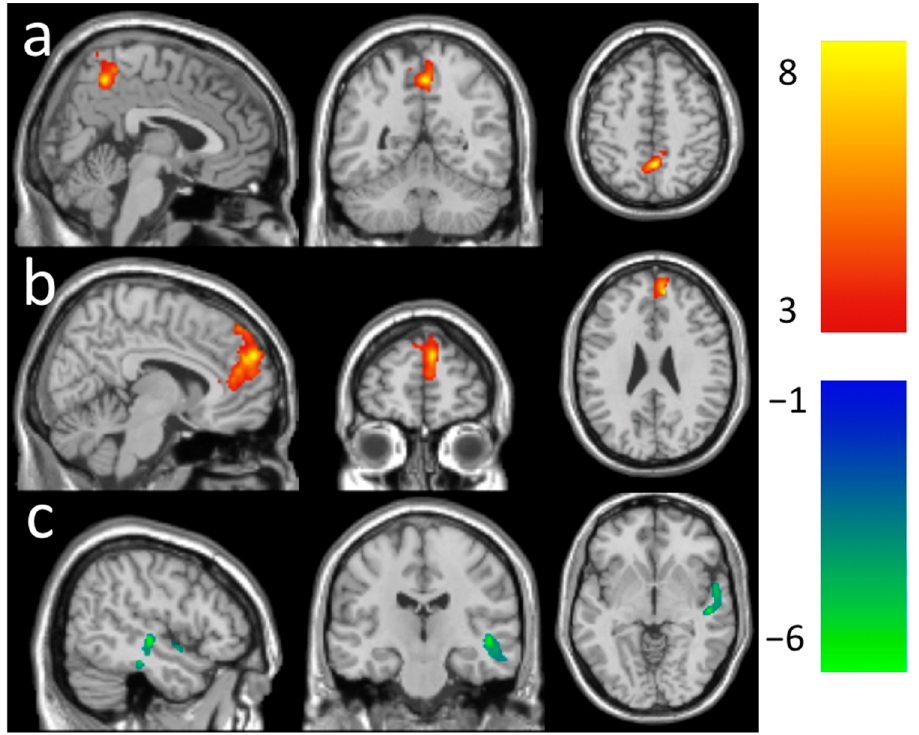
Figure 2. Increased functional connectivity ( a ) in the precuneus area (peak-T at 4, − 52, 52) with the left visual region seed ROI (LMT) and ( b ) in the frontal region (peak-T at (10, 26, 46)) with the right frontal eye field seed ROI (RFE). ( c ) Decreased functional connectivity in the superior temporal area (peak-T at (50, − 20, − 6)) with the left visual region seed ROI (LMT) after 2-month meditation practice at the thresholds of a voxel-level p -value of 0.005 and corrected cluster-level p -value of 0.05. The color bar shows the range of t -values. Table 2. Summary of cluster-level statistics for clusters showing significant longitudinal rsFC changes between the baseline and the